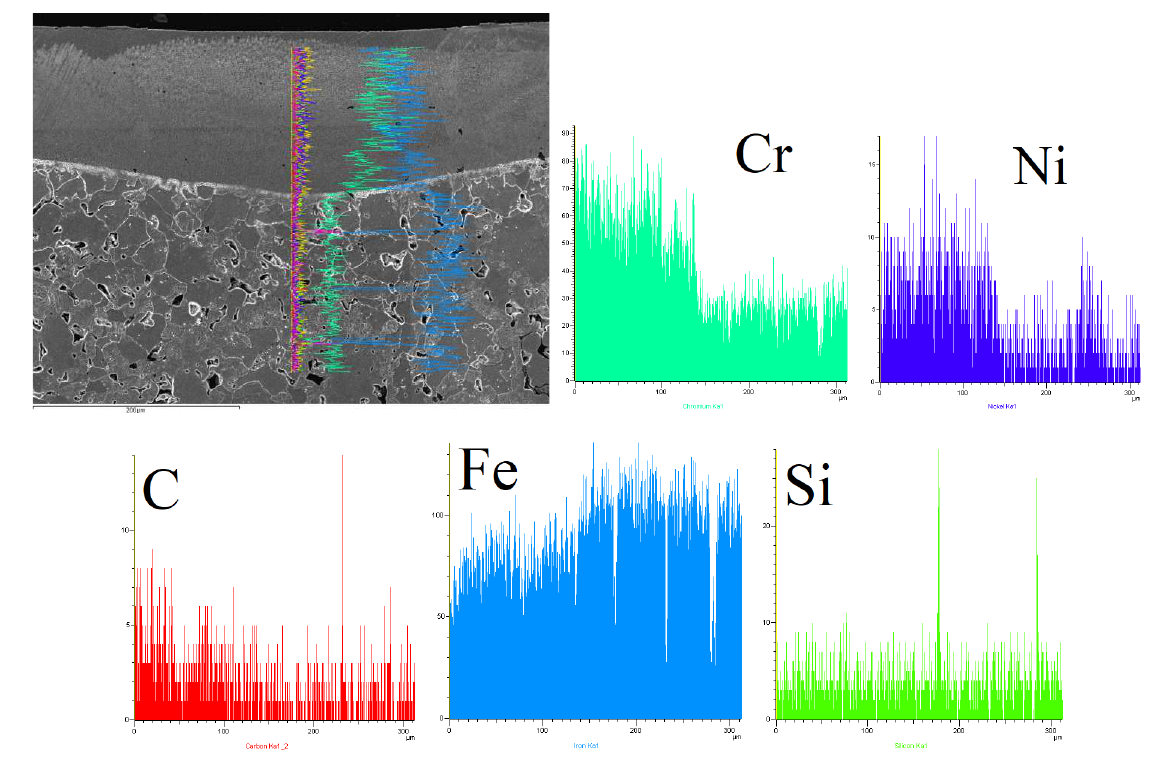
Figure 11. Line mapping analysis EDS on cross-section after laser alloying process for sample 1.